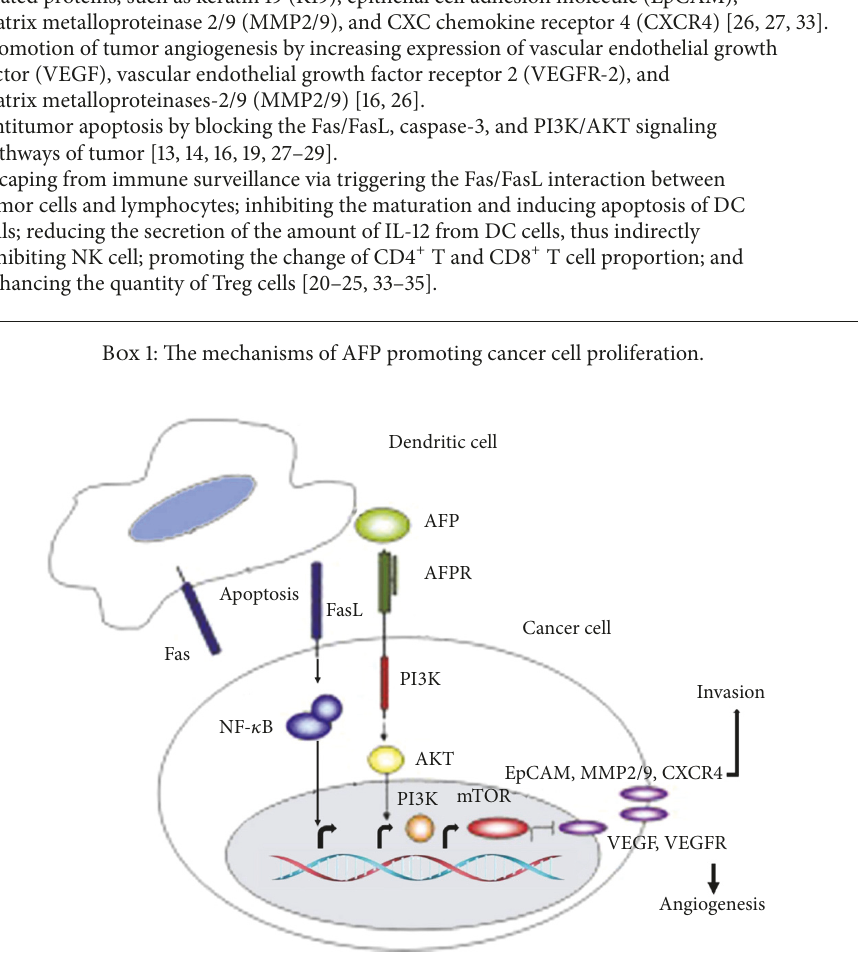
Figure1: MechanismsofAFPpromotingthegrowthofcancercells .AFPpromotedcancercellproliferation,invasion,andmetastasisbyinducing apoptosis of immune cells, binding AFP receptors (AFPR), and activating signal transduction